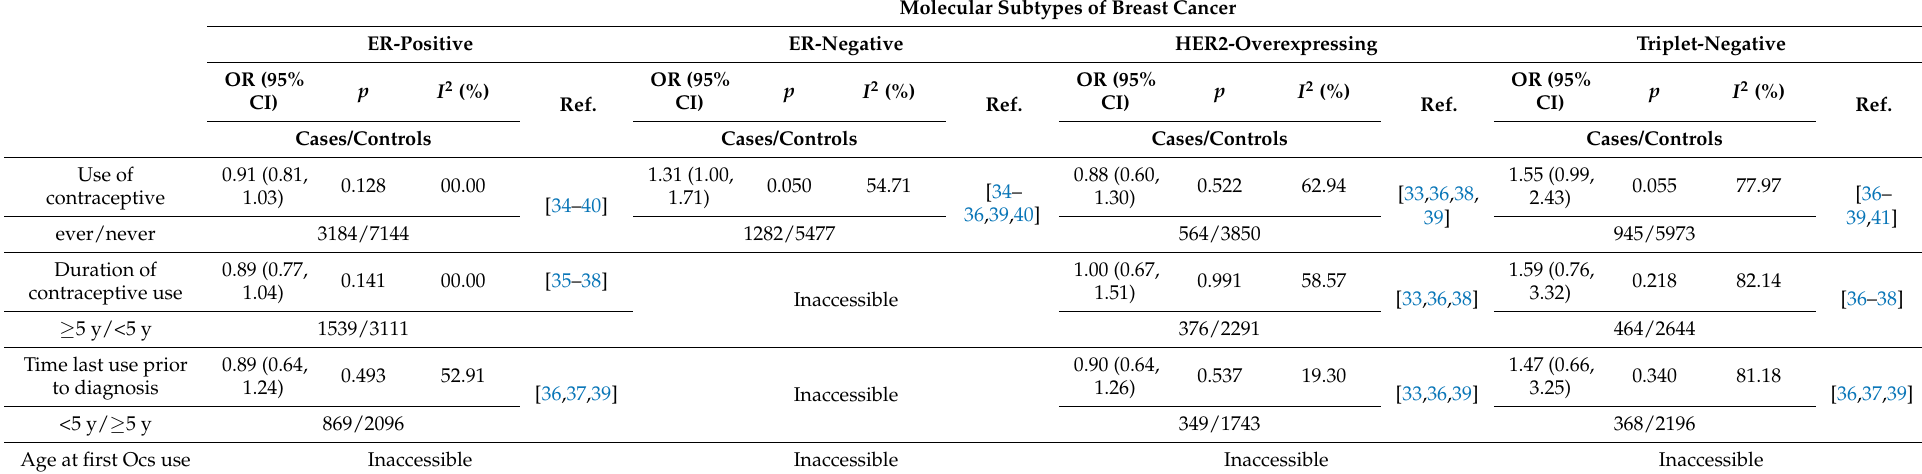
Table 2. Subgroup